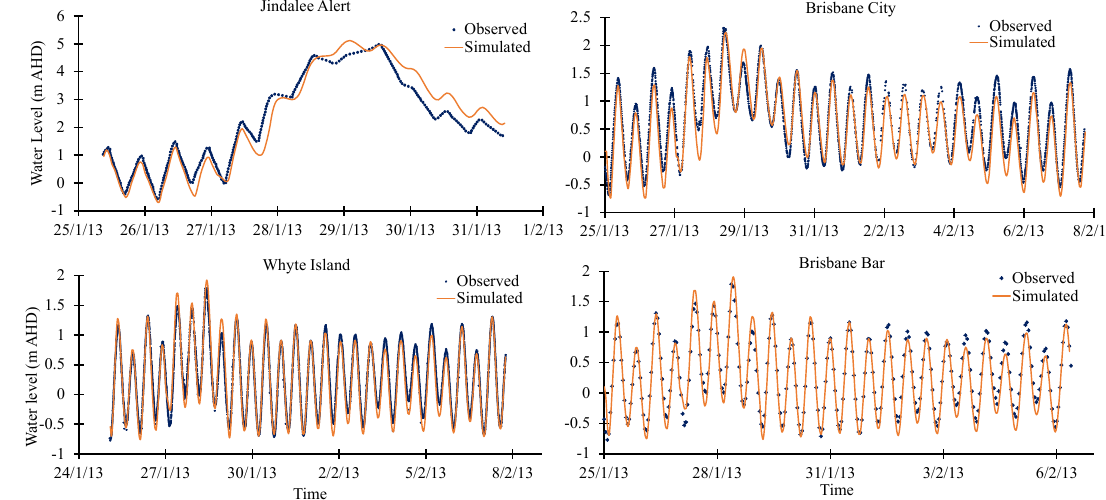
Figure 6. Observed and simulated water levels for the 2013 flood event at Jindalee Alert, Brisbane city, Whyte Island, and Brisbane Bar